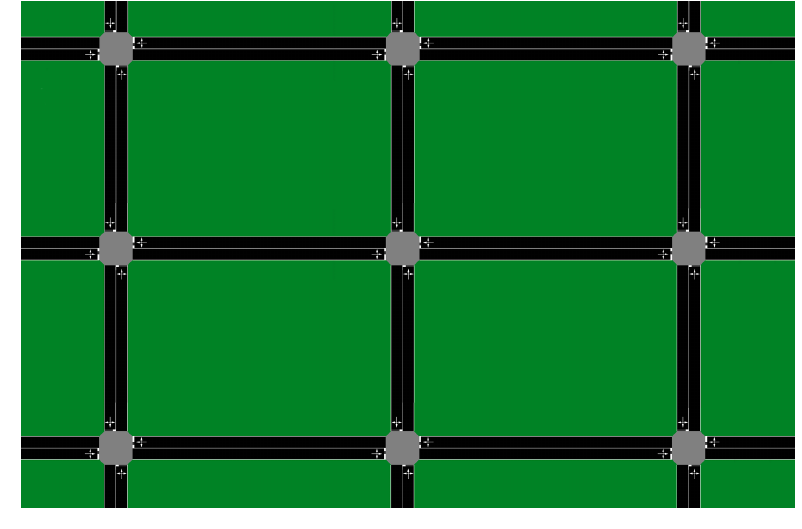
Figure 4. The 3-by-3